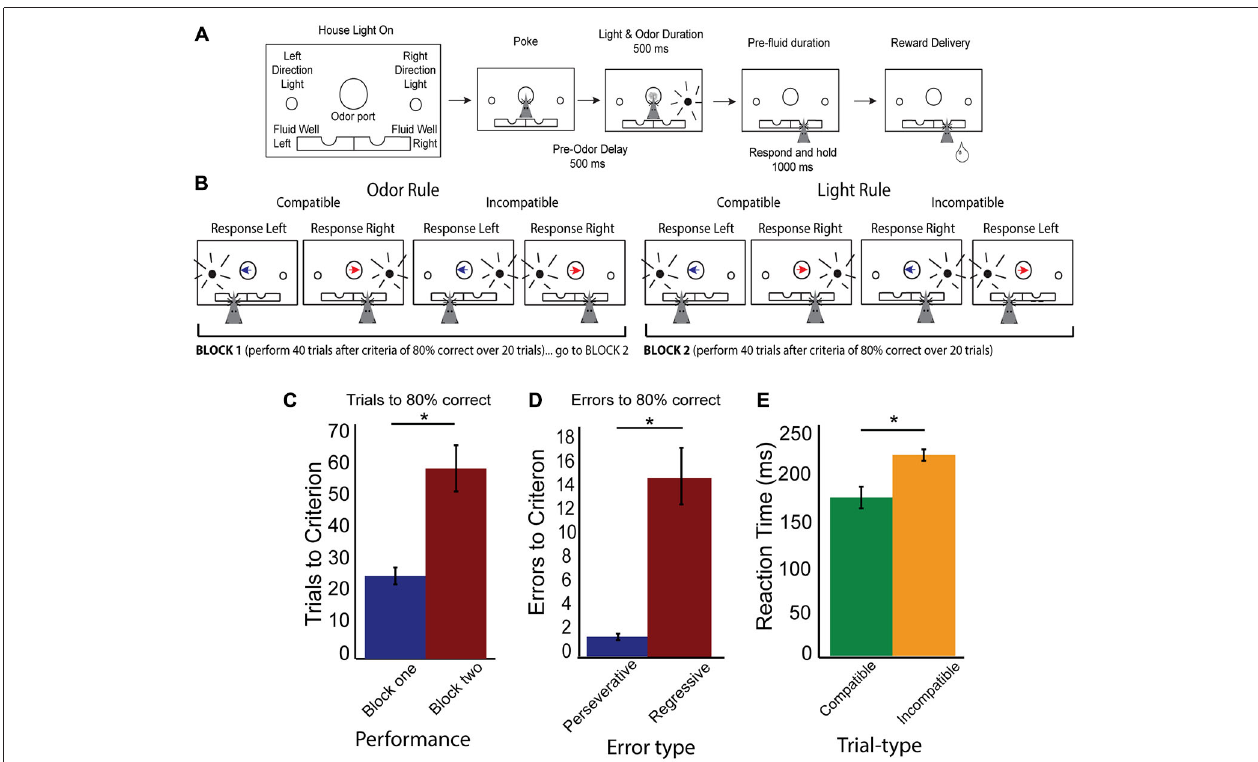
FIGURE 1 | Rule shifting behavior schematic and measures. (A) Schematic of odor port, fluid wells and simultaneous directional cues as well as flow chart of successful trial completion denoting specific time delays. (B) Example correct responses within different rule blocks, demonstrating compatible and incompatible trials with simultaneous directional information presented by both cues. Blue arrow indicates the “left” direction odor, Red arrow indicates the “right” direction odor, while black radiating circle represents the side of the light. Rat head represents the correct choice made by a rat which would have previously received the simultaneous presentation of both odor and light cues before making his choice. (C) Data showing increased number of trials required to reach criterion after a switched rule, with trials to criterion in block one (blue bar) and block two (red bar). (D) Data demonstrating a significant number of errors are regressive (red bar), rather than perseverative (blue bar). (E) Reaction time data (cue offset to port exit), demonstrating significant slowing on incompatible (orange bars) compared to compatible trial-types (green bars). Significance of at least p < 0.05 denoted with asterisk ∗